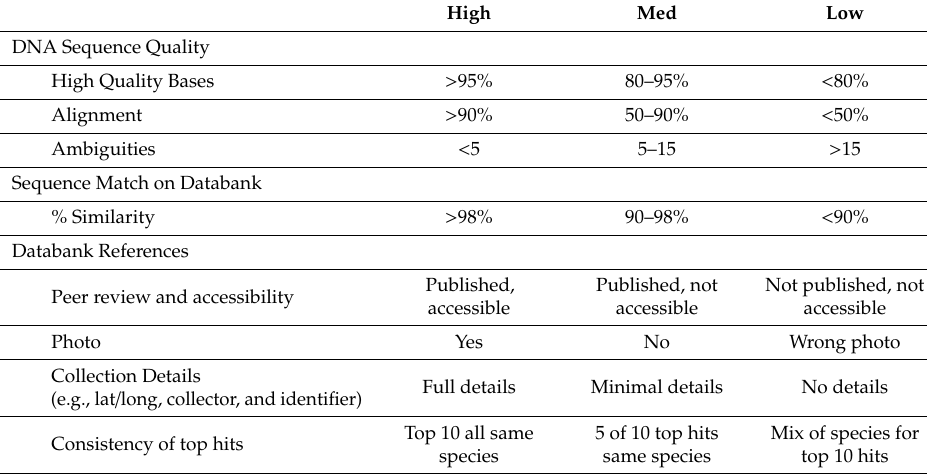
Table 1. Criteria to assign confidence to species identification based on DNA sequence quality, percent match with sequence to databanks, and quality of databank references: these criteria were evaluated, and sequences were given a final confidence score (high, medium, and